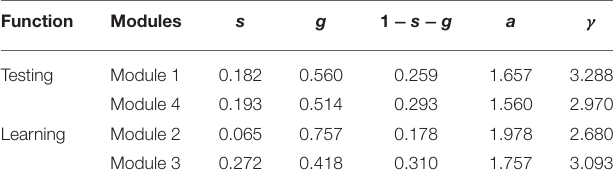
TABLE 6 | The mean item parameters for each